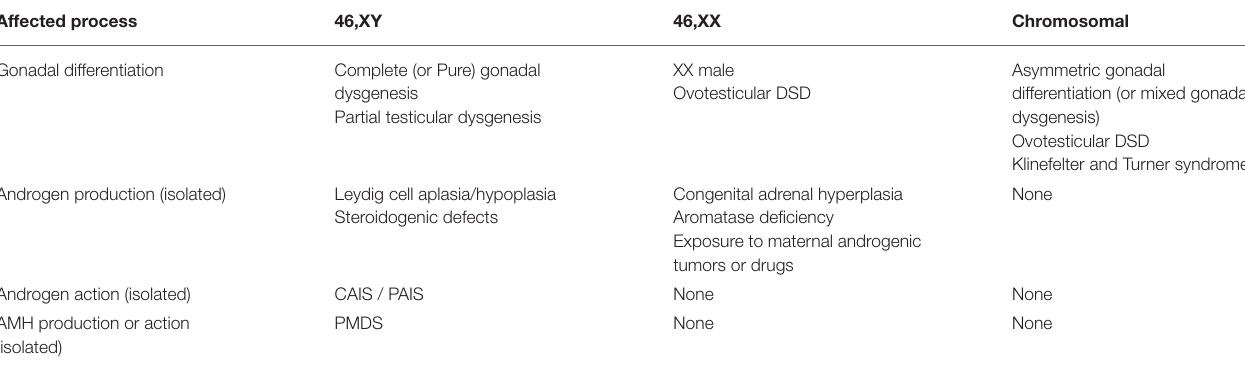
TABLE 1 | Classification of disorders of sex development (DSD) according to the karyotype and the underlying pathogenesis. Affected